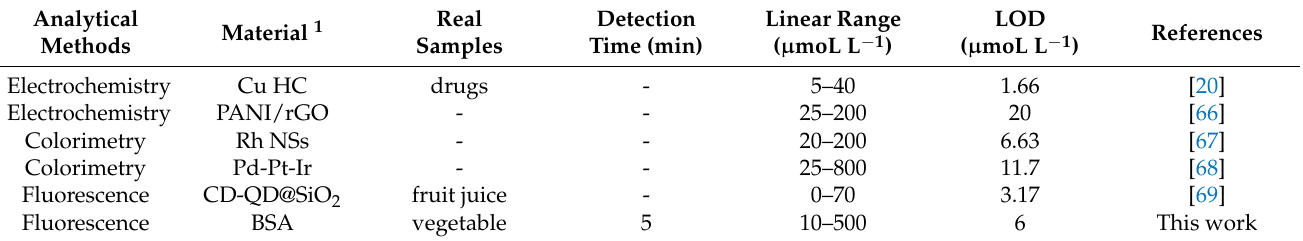
Figure 8. ( A ) Fluorescence emission spectra of BSA in the presence of various concentration of AA (0, 10, 20, 40, 80, 200, 400 and 500 µ moL L − 1 ) at 298 K. ( B ) Corresponding working curve for AA detection. Table 1. Comparison of AA sensor detection with other rapid methods.